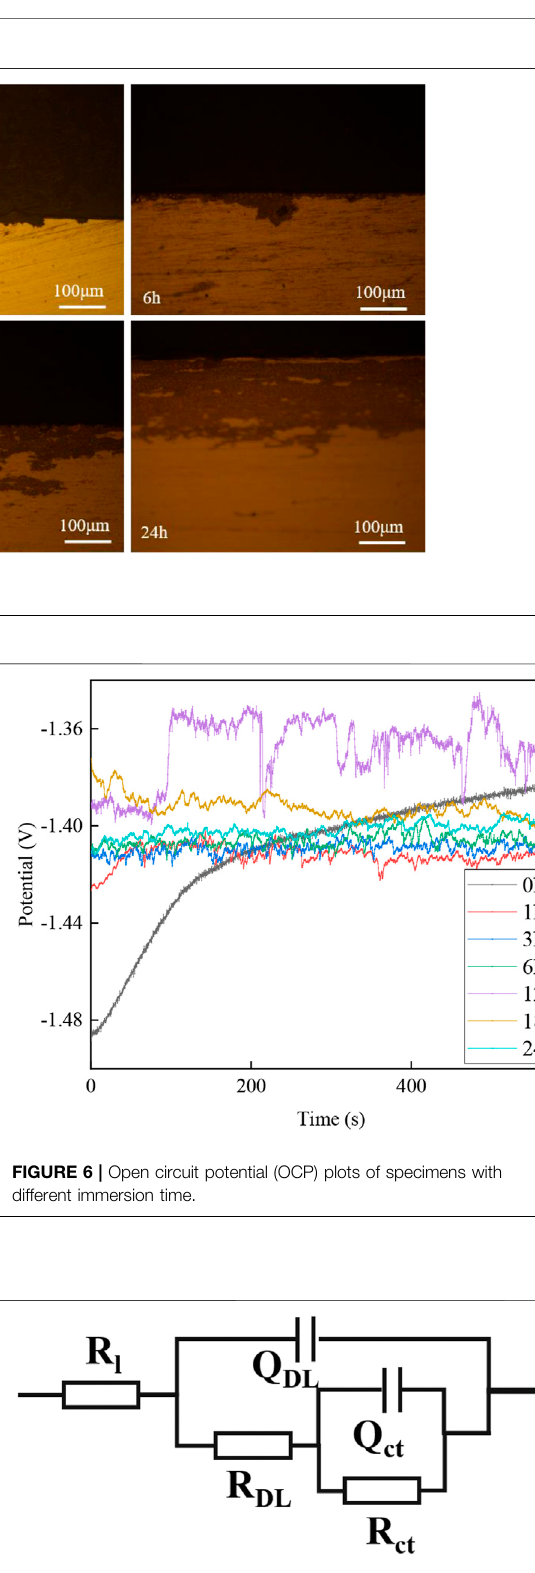
FIGURE 7 | Electrical equivalent circuit model for the EIS results, R (Q (R (QR))) (R l stands for solution resistance, Q DL and R DL are electric double layer capacitance and resistance respectively, Q ct and R ct arereactioncapacitance and resistance respectively; Q is a constant phase angle